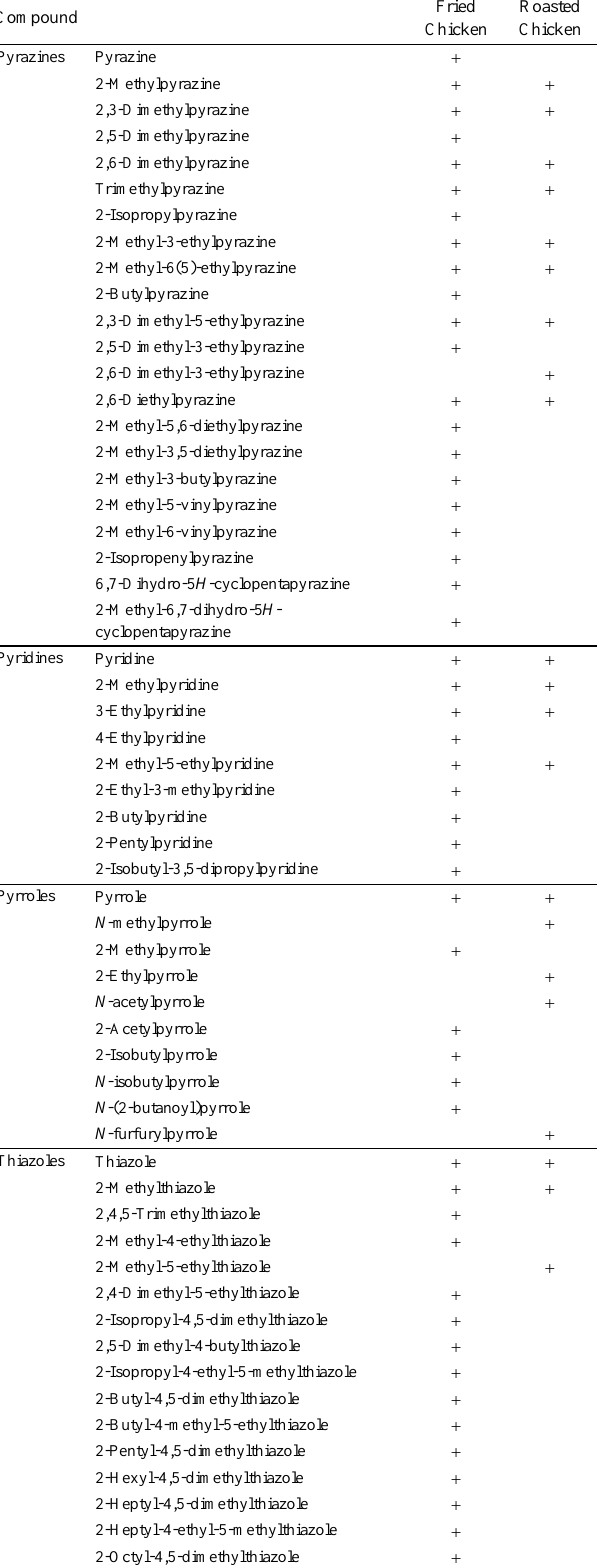
Table 6. Heterocyclic compounds identified in fried and roasted chicken flavours (adapted from Shi and Ho, 1994) Compound